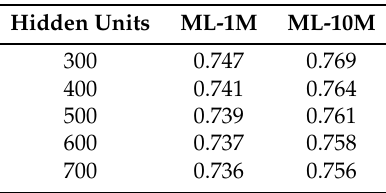
Table 2. Test RMSE with varying configurations about size of hidden units on the MovieLens